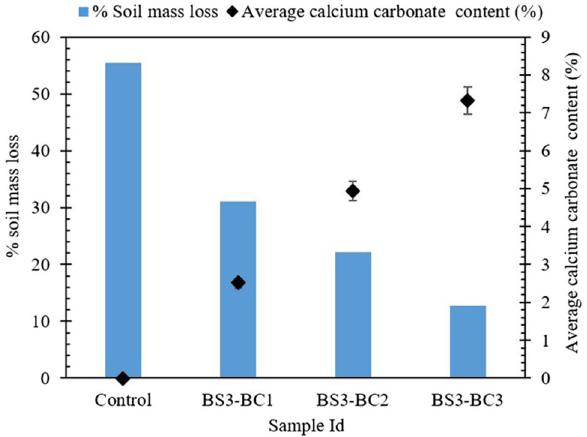
Figure 7. Weight of the eroded soil (%) after the hydraulic flume